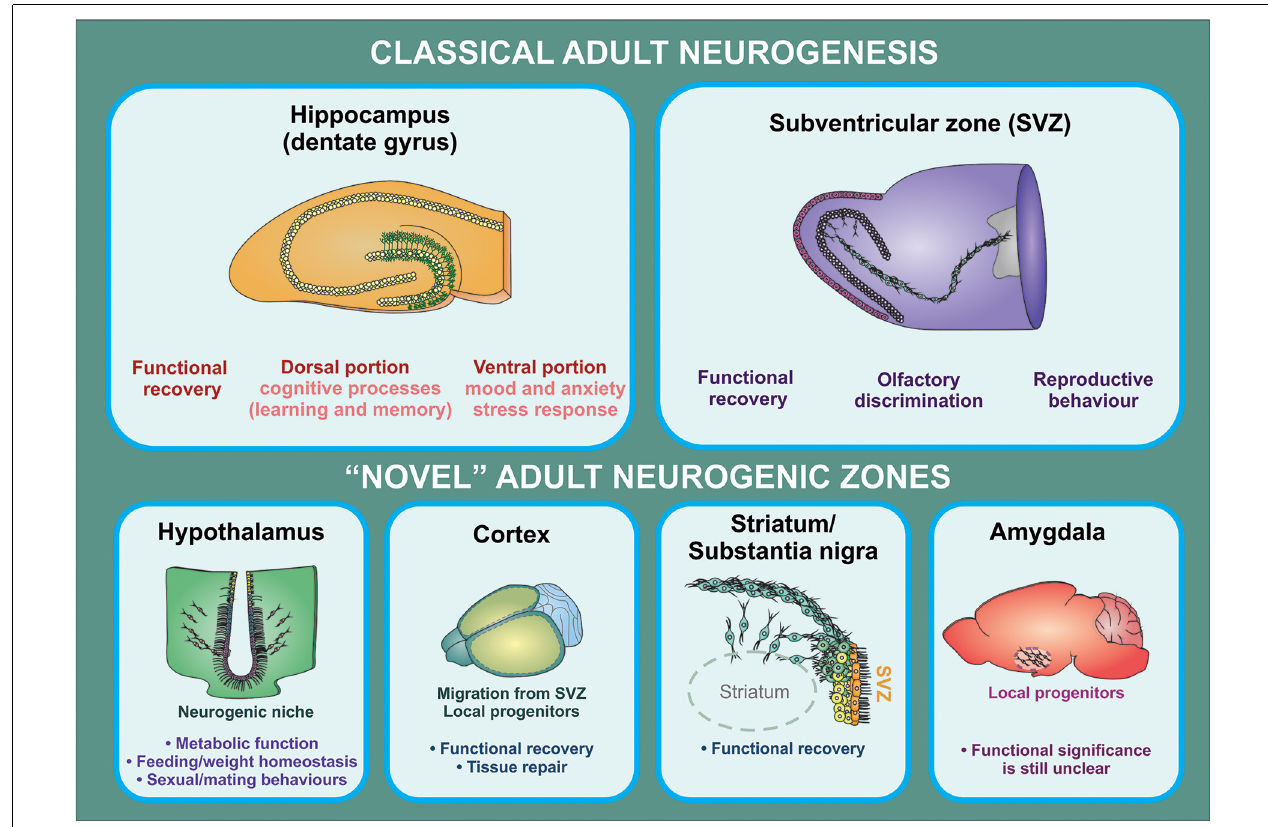
FIGURE 2 | Functional implications of adult neurogenesis. The contribution of adult neurogenesis to physiological and pathological processes mediated by the hippocampus and the OB is supported by a substantial amount of evidence from rodent studies. In the hippocampus, this process regulates specific aspects of cognitive (dorsal portion) and affective (ventral portion) processing, while newborn neurons generated in the SVZ were shown to contribute to olfactory function and reproductive behavior (in birds). There is also increasing evidence indicating that neural progenitors may exert a relevant role in the regulation of hypothalamic function (particularly in metabolic function/feeding behaviors). On the other hand, it is still unclear whether progenitor cells found in other brain regions have a functional significance other than participating in recovery processes triggered following injury, neuronal loss, or